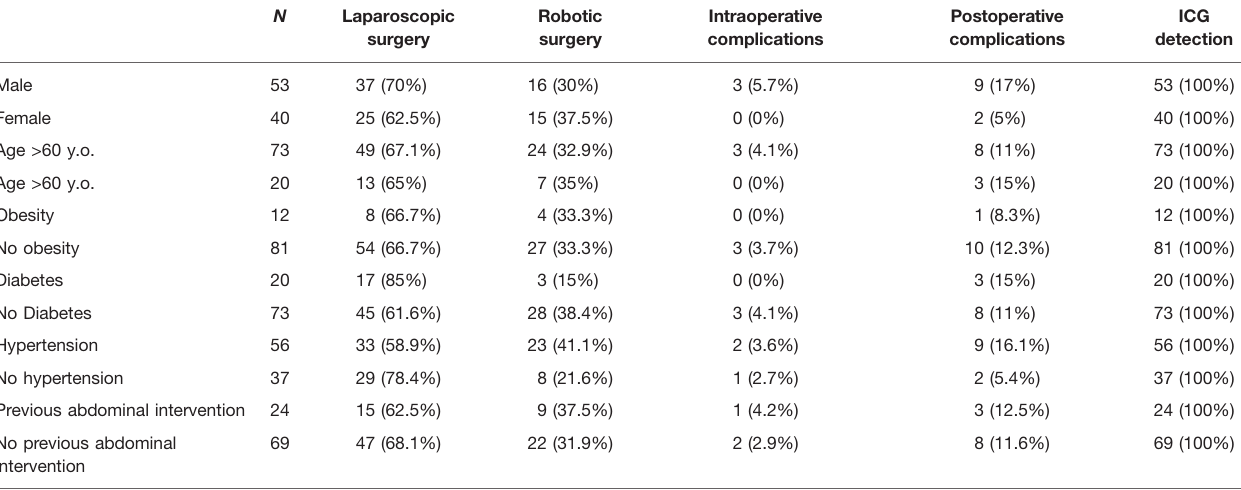
TABLE 4 | Surgical technique, complications, and ICG detection according to patient